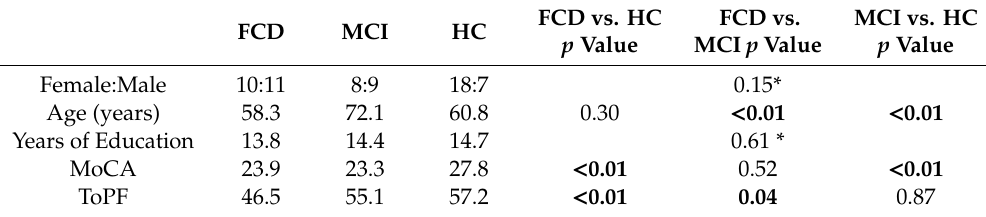
Table 1. Group demographics and cognitive functioning (mean values; significant p values in